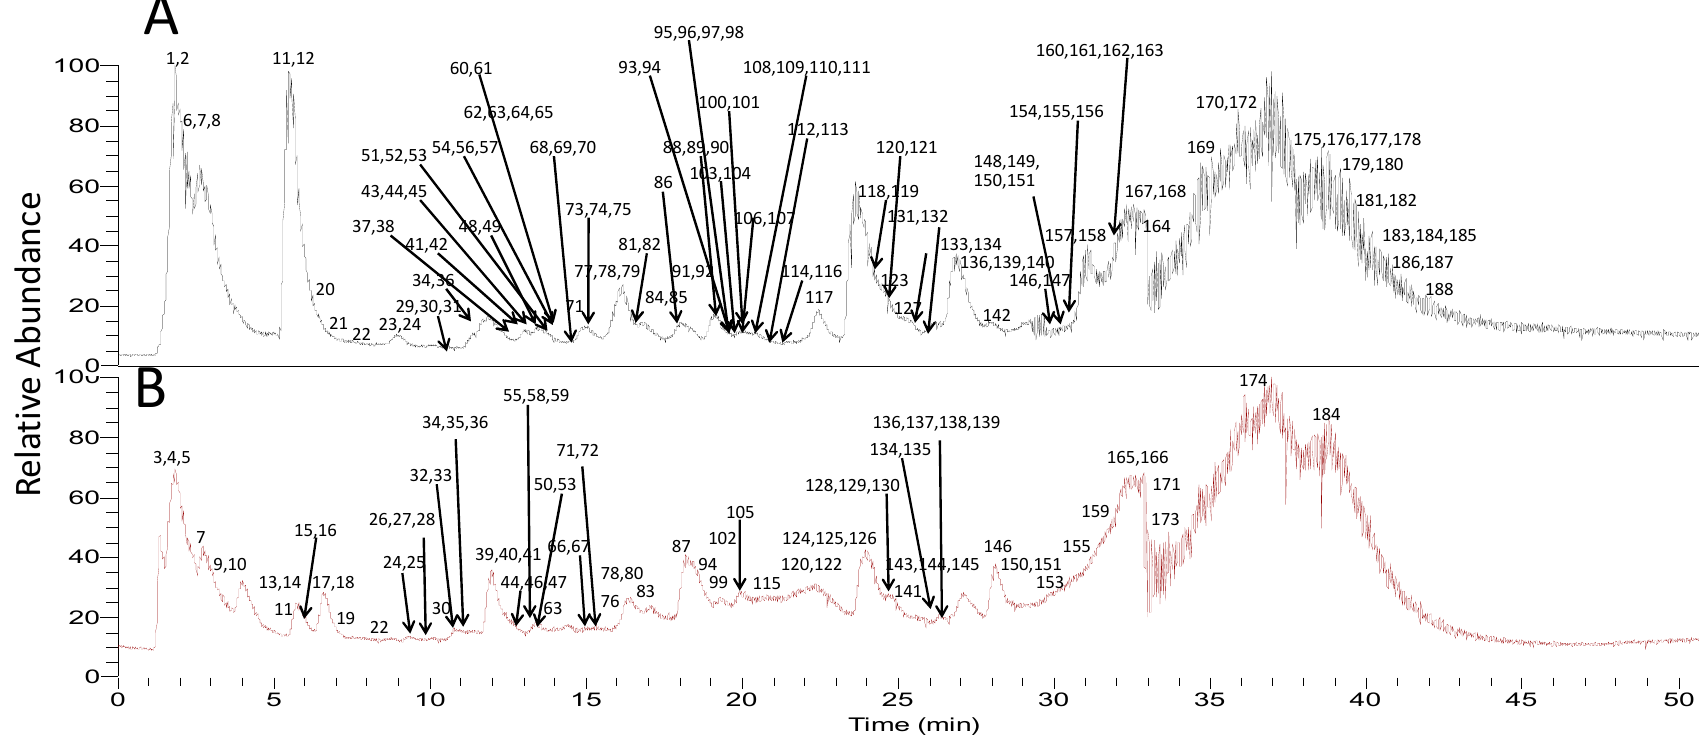
Figure 2. Total ion chromatograms (TICs) of the extract of Myrica rubra by UPLC-PDA-HRMS. ( A ) Negative ion mode; ( B ) positive ion mode.